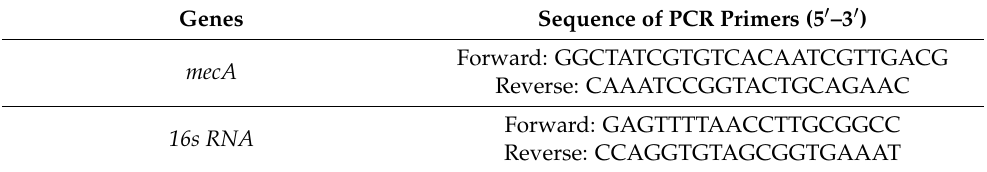
Table 1. Oligonucleotides used for qRT-PCR.